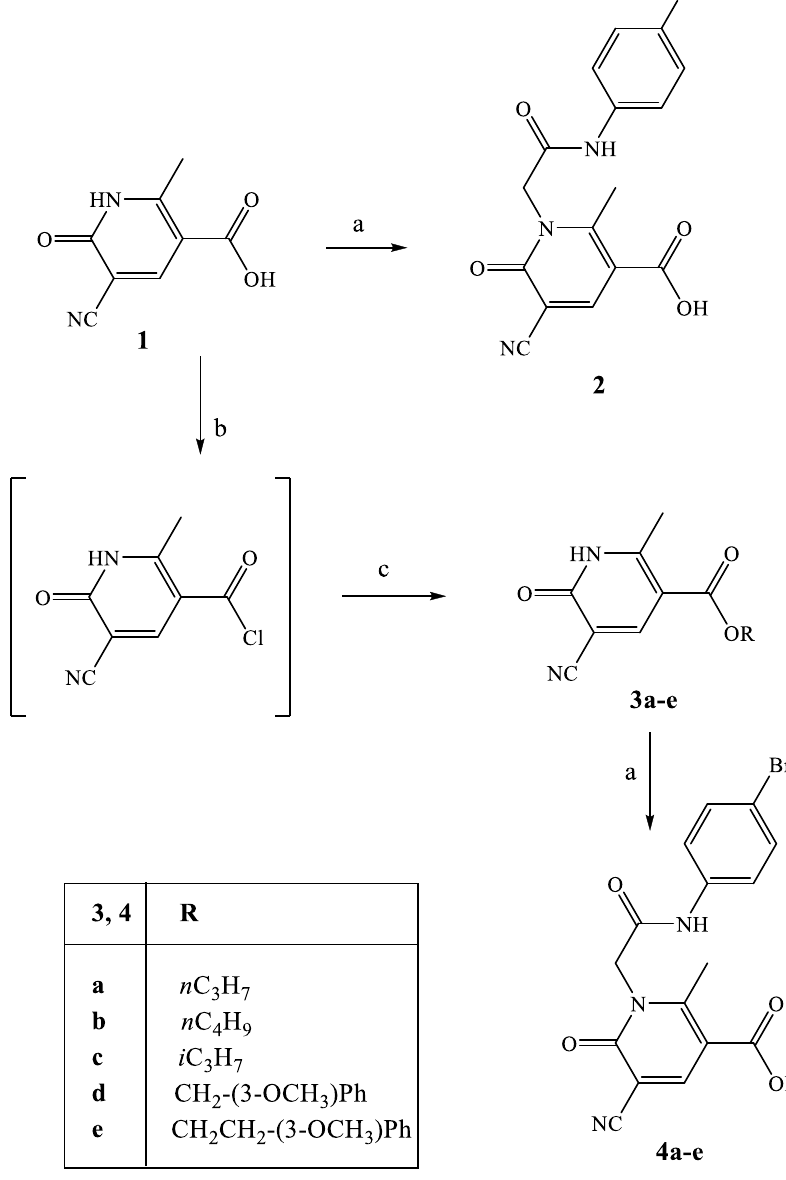
Scheme 1. Synthesis of compounds 2 and 4a–e. Reagents and conditions: (a) 4-bromophenyl- 2-chloroacetamide [27], K 2 CO 3 , anhydrous CH 3 CN, reflux, 3–30 h. (b) SOCl 2 , Et 3 N, reflux, 8 h. (c) Appropriate alcohol, anhydrous THF, r.t., 1.5–4